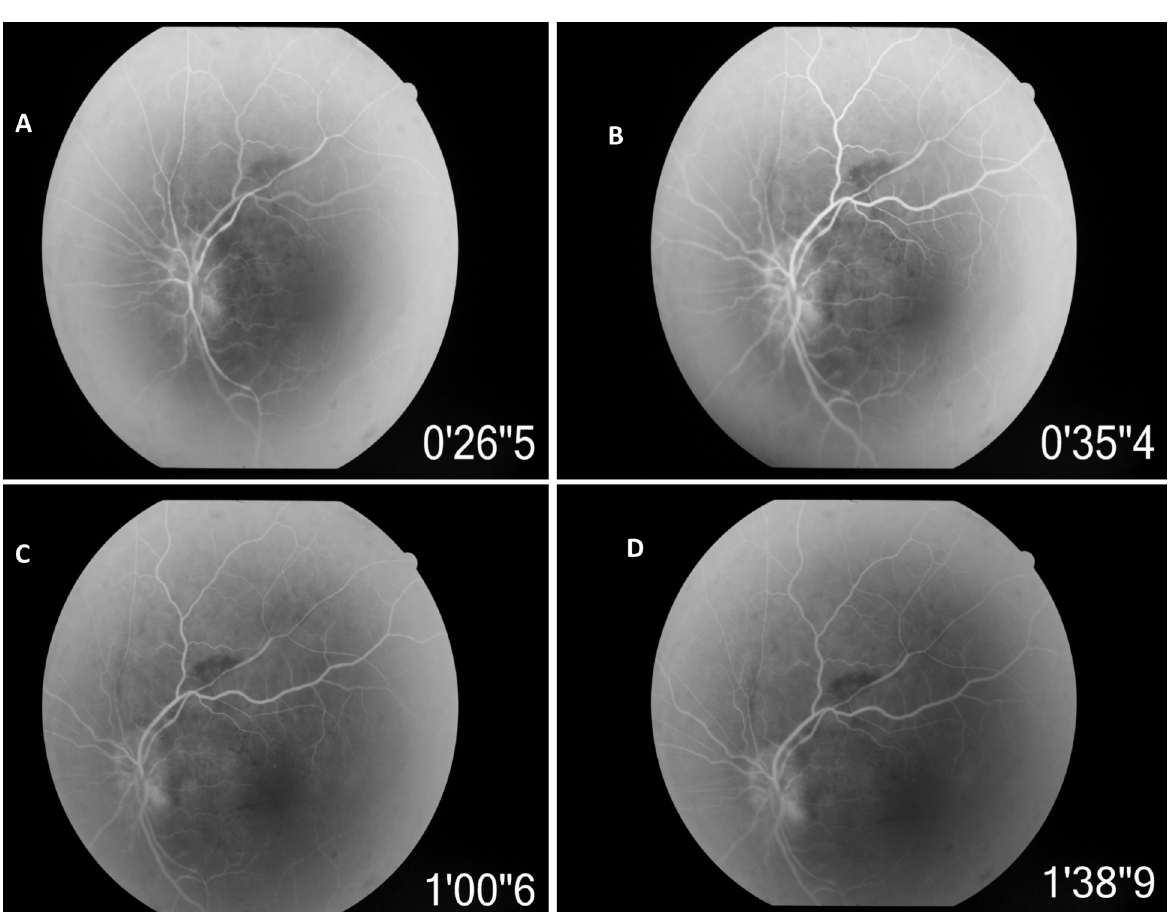
Figure 2: Fundus fluorescein angiography (FFA) of LE showing delayed filling of the disc especially superior part in the early phase, irregular filling of retinal arterioles and staining of the disc in the late